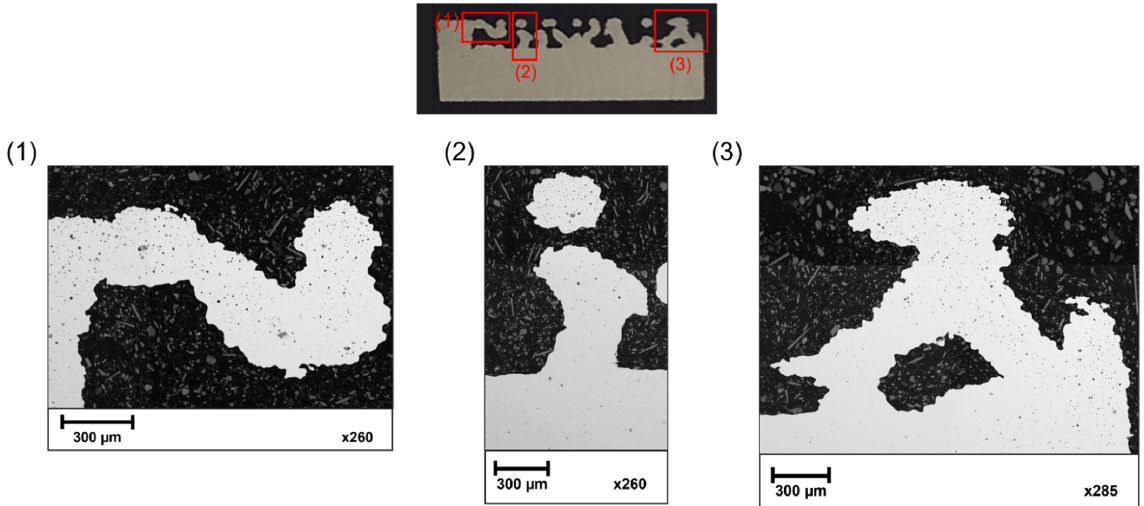
Figure 10. The SEM (PHENOM PRO) image of struns of the Voronoi structure before modification with DLC coating was obtained from a cross-section.